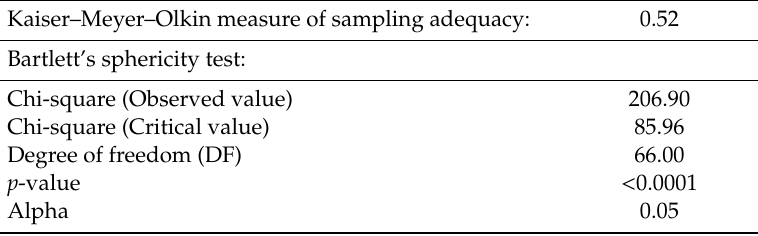
Table 5. Bartlett’s sphericity and the Kaiser–Meyer–Olkin (KMO) test. Kaiser–Meyer–Olkin measure of sampling adequacy: